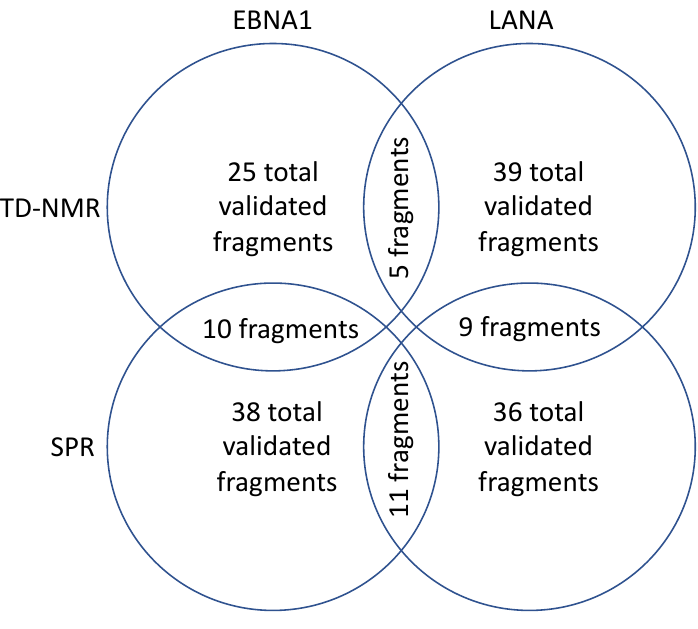
Figure 5. An analysis of the fragments from the screen.